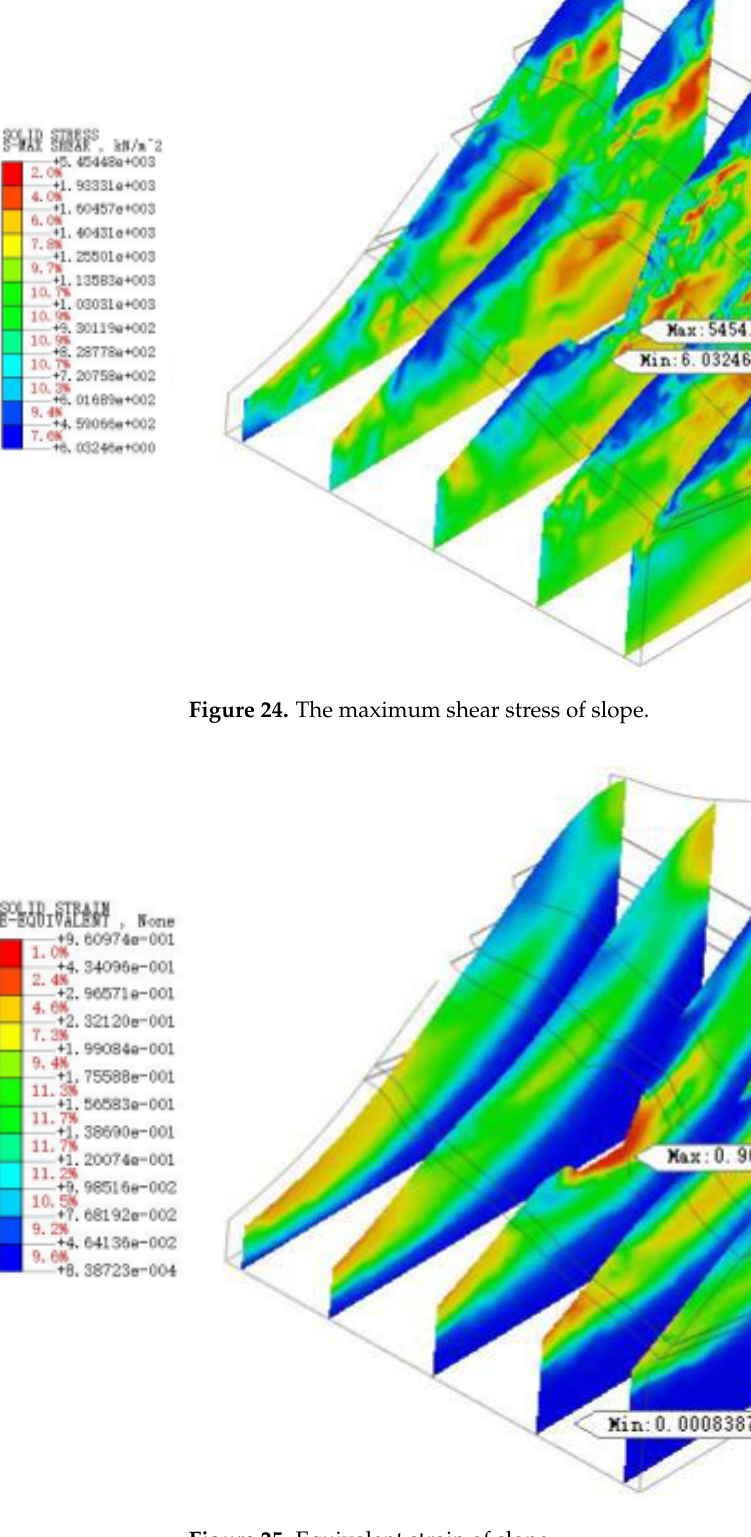
Figure 25. Equivalent strain of